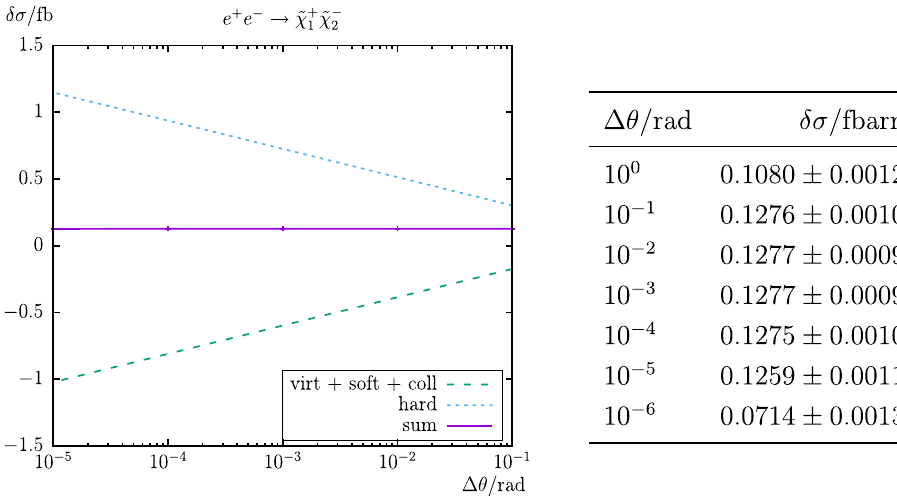
Fig. 3 Phase space slicing method. The different contributions to the one-loop corrections δσ( e + e − → ˜ χ ± S (see Table 2 below) as a function of (cid:7) E / E with fixed (cid:7)θ/ rad = 10 − 2